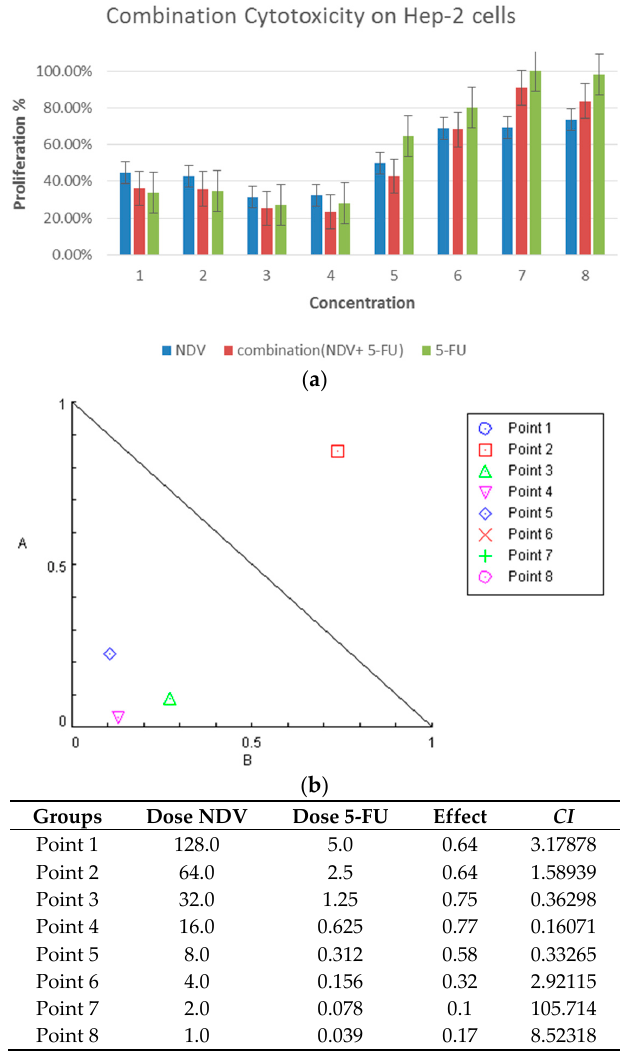
Figure 1. Cytotoxicity of the combination on Hep-2 laryngeal carcinoma cells. ( a ) Cytotoxic effect of 5-FU, NDV, or both, on Hep-2 cells in vitro . Hep-2 cells were treated with 5-FU (5 µg in two-fold serial dilutions up to 0.039 µg/mL), NDV (128 HUA with two-fold serial dilutions), or a combination of the two treatments. The results for the treated groups are expressed as the cell proliferation rate compared with untreated control cells grown at identical conditions. HUA: hemagglutination unit, which is the smallest virus concentration leading to visible erythrocyte agglutination; ( b ) isobologram analysis showing synergism between NDV and 5-FU as the point of combination is at the lower left of the hypotenuse, indicating the effect is synergistic at a 50% growth inhibition dose for the Hep-2 tumor cell line. In the figure we can see four points that is less than or equal to 1; and ( c ) table showing the combination index data for each dose.